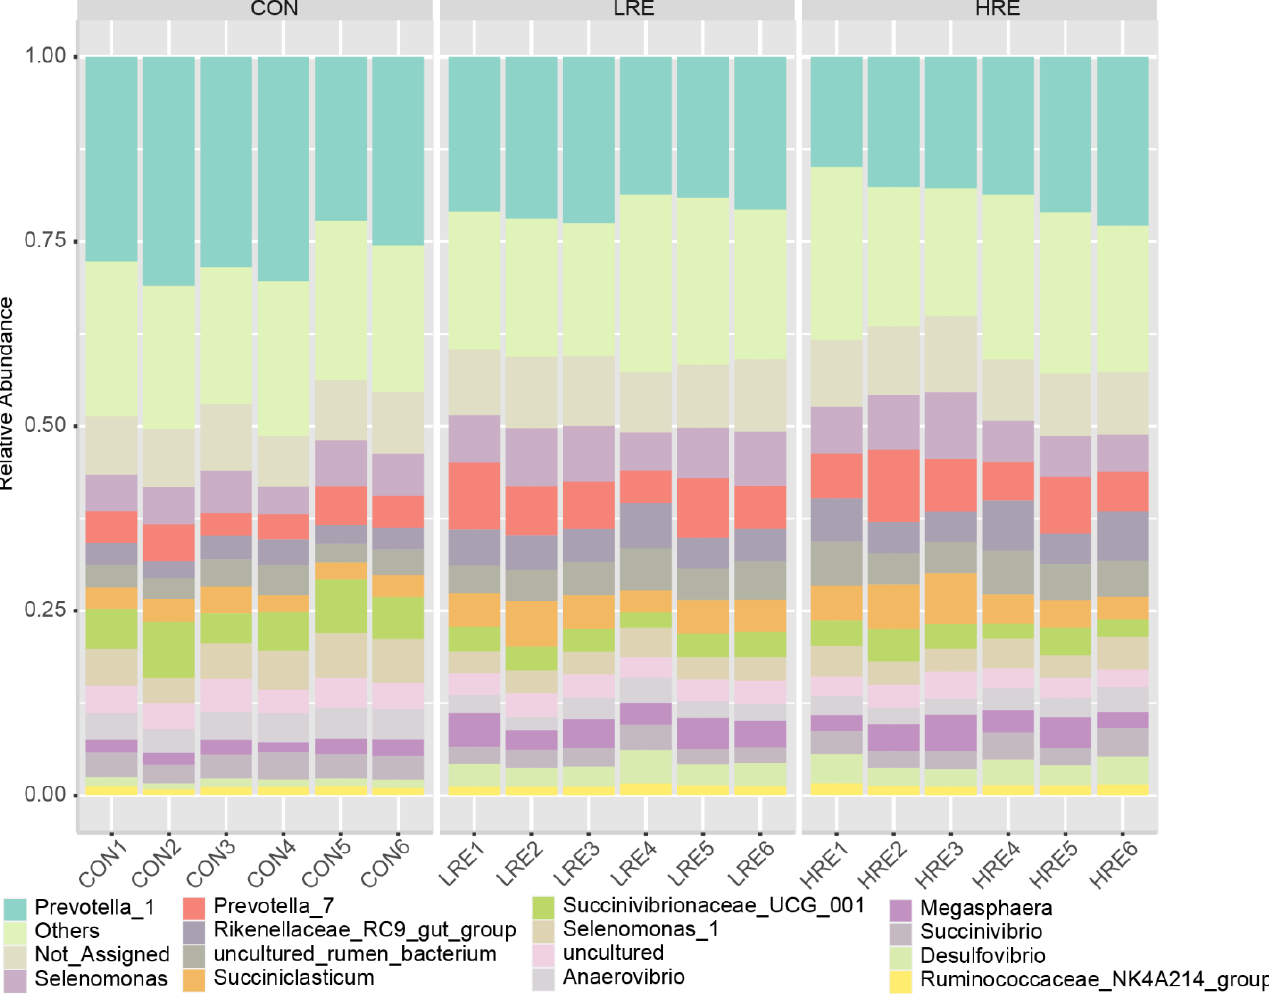
Figure 2. Genera composition of the microbiota from in vitro fermentation technique. Only the top 15 abundance genera were included in this figure. CON, no supplementation; LRE, low-dose rosemary extract supplementation; HRE, high ‐ dose rosemary extract supplementation.